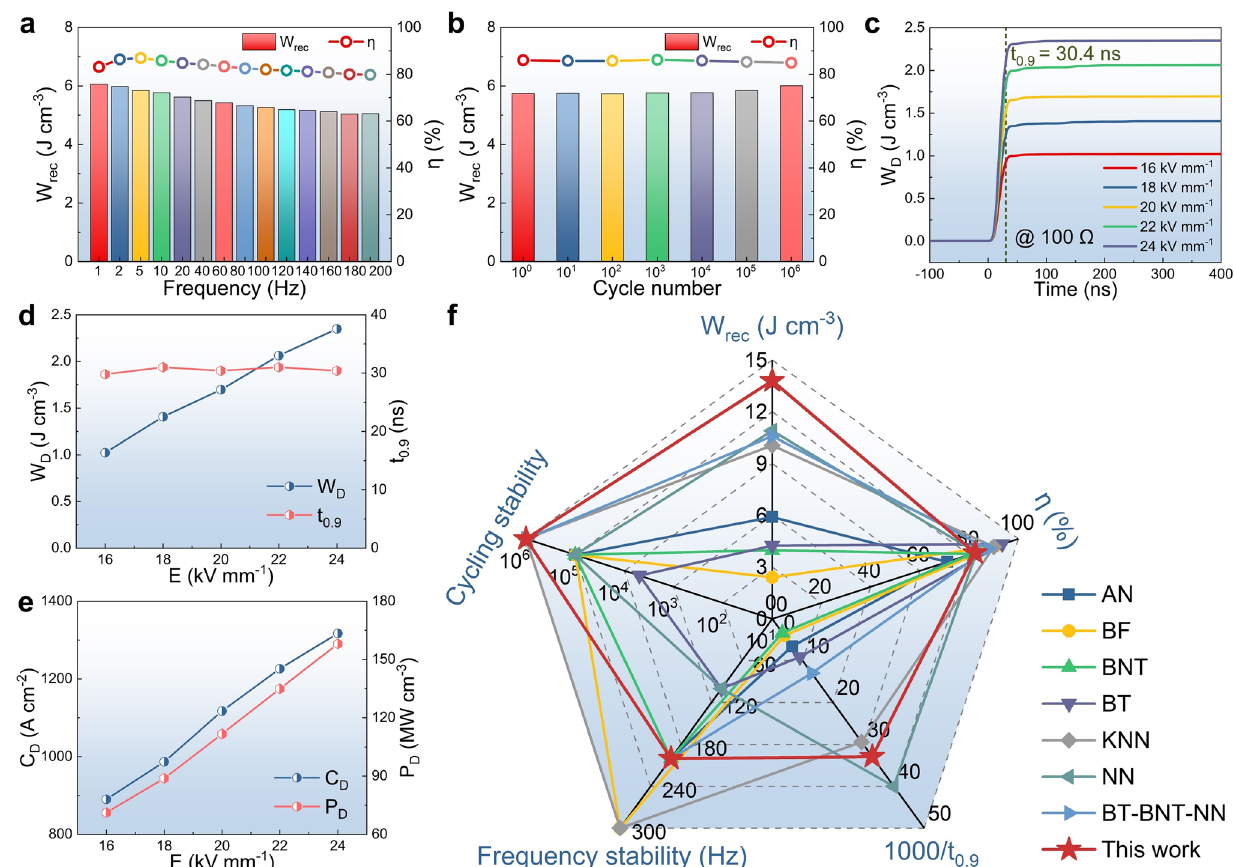
Fig. 6 Stability and charge/discharge properties of BNTFN-1/3 energy storage ceramics. ( a ) Frequency-dependent W rec and η under 40 kV mm −1 . ( b ) W rec and η as a function of the cycle number under 40 kV mm −1 . ( c ) Calculated overdamped discharge density W D , and ( d ) W D and t 0.9 values under different electric fields ( R o = 100 Ω). ( e ) C D and P D values in underdamped discharge circuit under different electric fields. ( f ) Comparisons of comprehensive properties ( W rec , η , t 0.9 , frequency and cycling stability) between BNTFN-1/3 ceramic and some representa- tive energy storage ceramics with excellent comprehensive performance of different